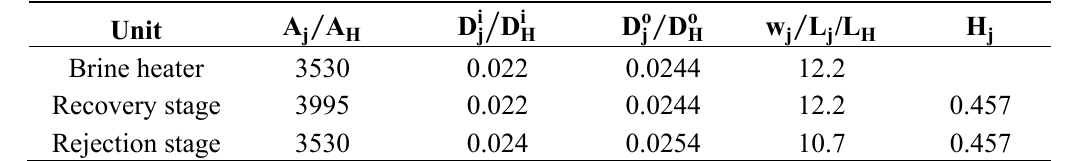
Table 1. Constant parameters.